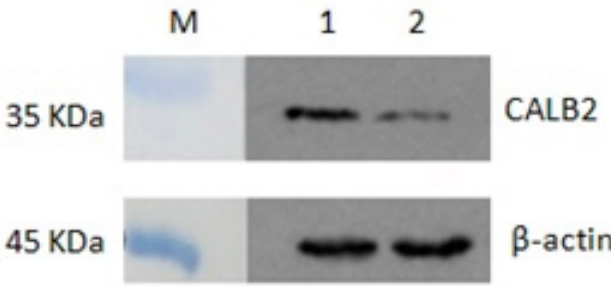
Figure 6. Expression analysis of the CALB2 protein in the testis and ovary of P. olivaceus by western blot analysis. M, protein marker; 1, testis; 2, ovary.